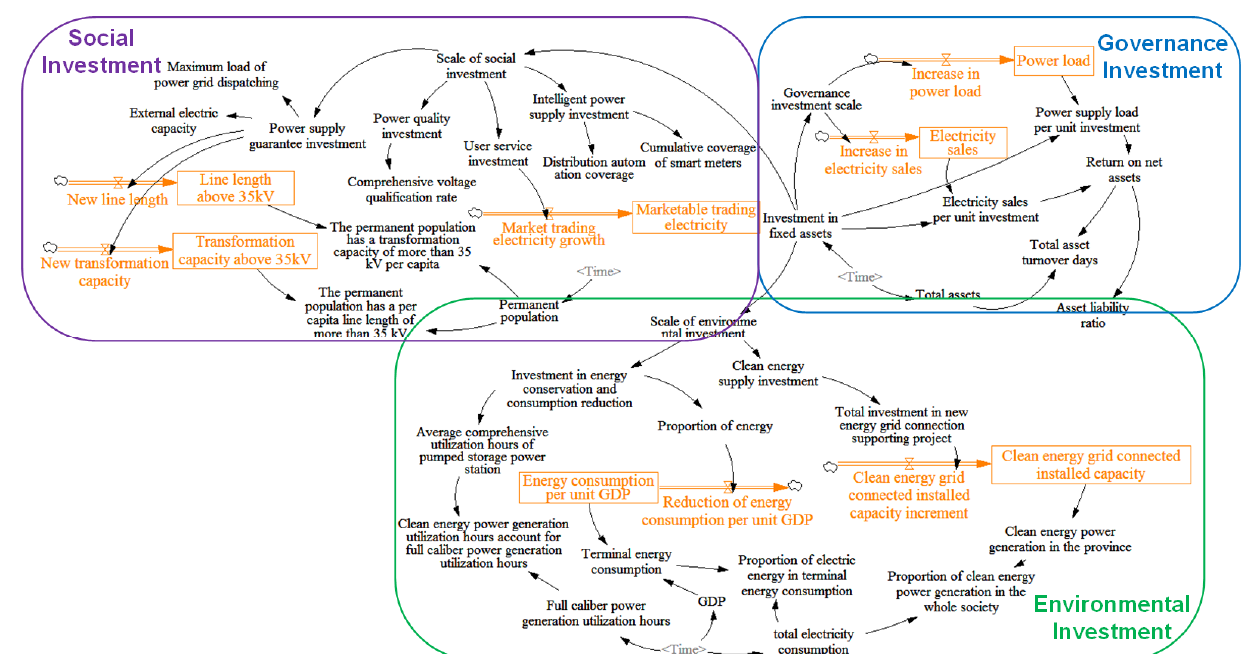
Figure 6. SD Model of ESG Investment of Power Grid Company .